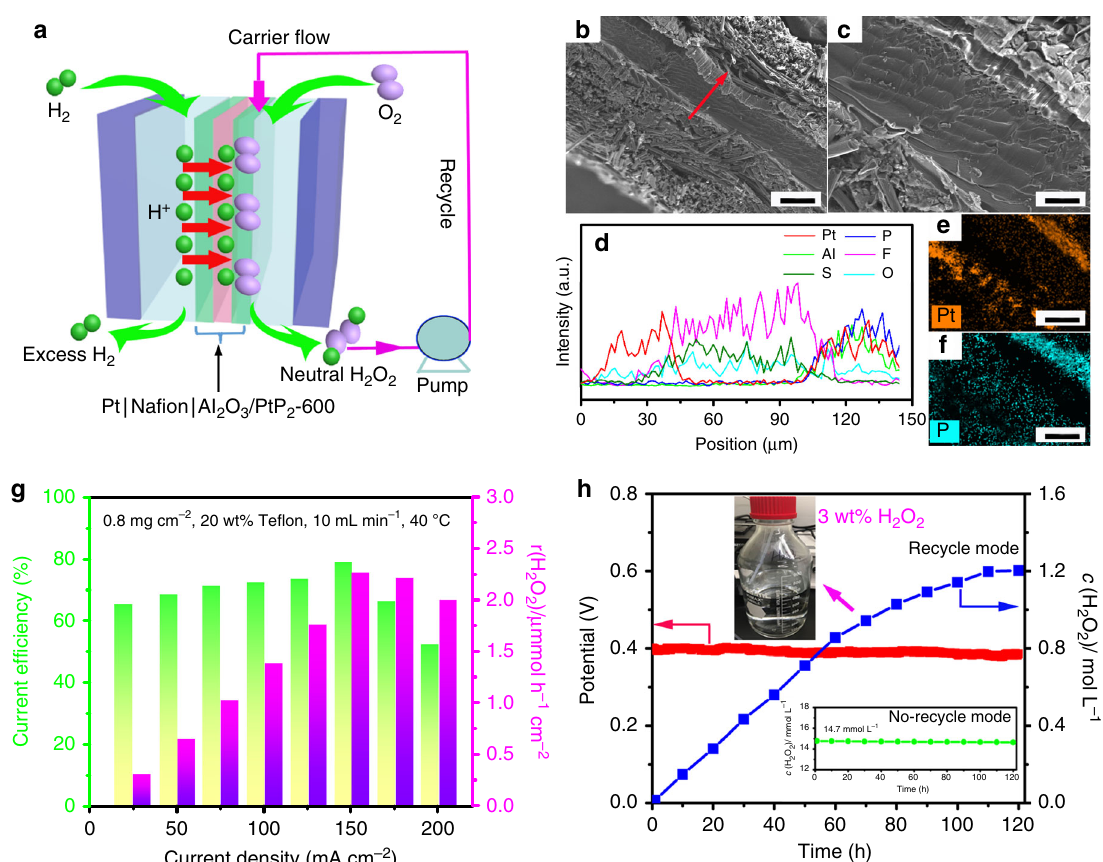
Fig. 5 Performance of polymer electrolyte membrane fuel cell (PEMFC). a Schematic diagram of PEMFC for O 2 -to-H 2 O 2 production with product recycling. b , c Cross-sectional SEM images; scale bar, b 100 µ m; c 20 µ m. d line-scan elemental distribution, and e , f elemental mapping of Al 2 O 3 /PtP 2 -600 based MEA; scale bar, 50 µ m. g Current ef fi ciency and H 2 O 2 production rate as a function of current density under optimized conditions. h Time- dependent neutral H 2 O 2 concentration measured at a constant potential of 0.4 for 120 h. The accumulated H 2 O 2 concentration in 600 mL when the product is continuously cycled through the system. Concentration reaches a metric value of 3.0 wt% after 65 h (inset of Fig.